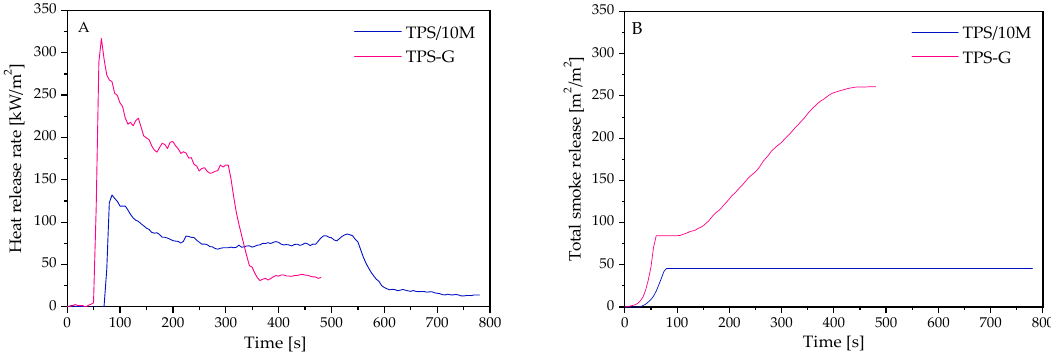
Figure 4. Representative curves of: ( A )—heat release rate, ( B )—total smoke release of investigated TPS materials.